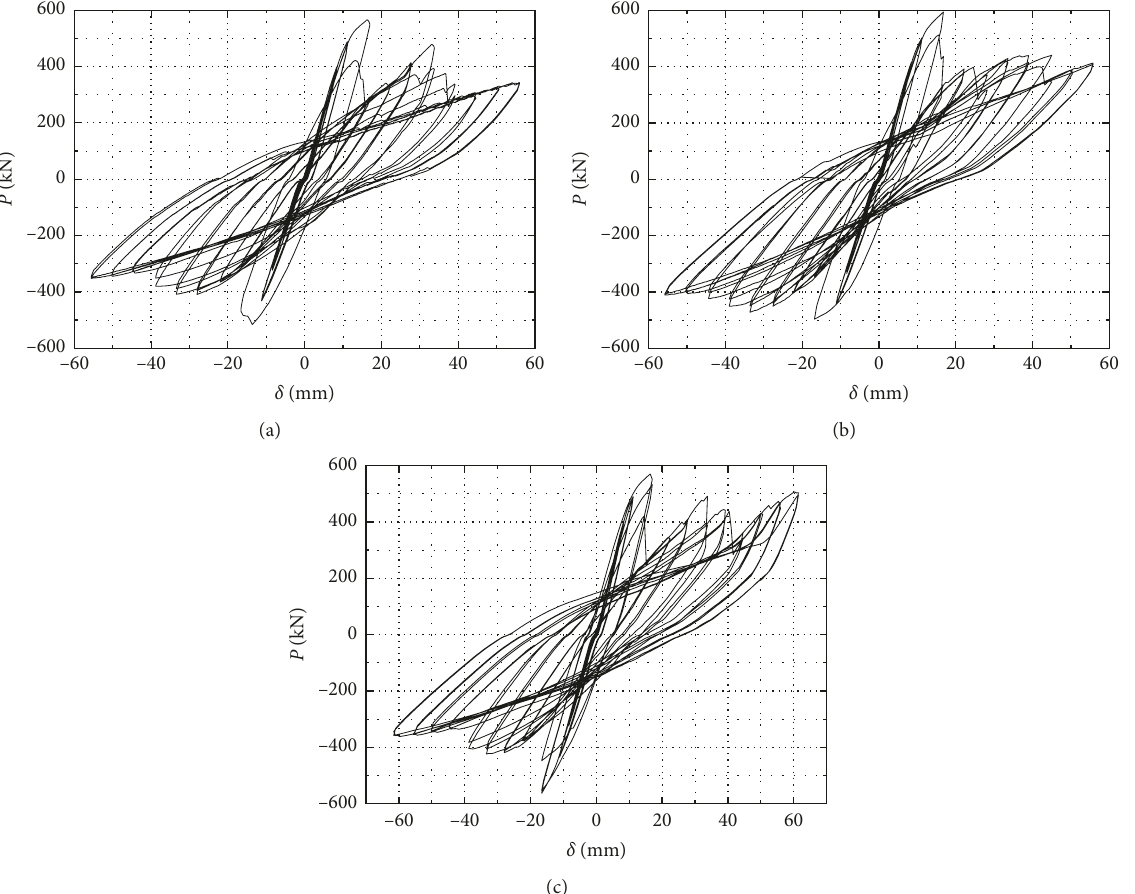
Figure 7: Hysteresis curves of the specimens. (a) Hysteresis curve of the specimen C-JA. (b) Hysteresis curve of the specimen C-JB. (c) Hysteresis curve of the specimen C-JC.